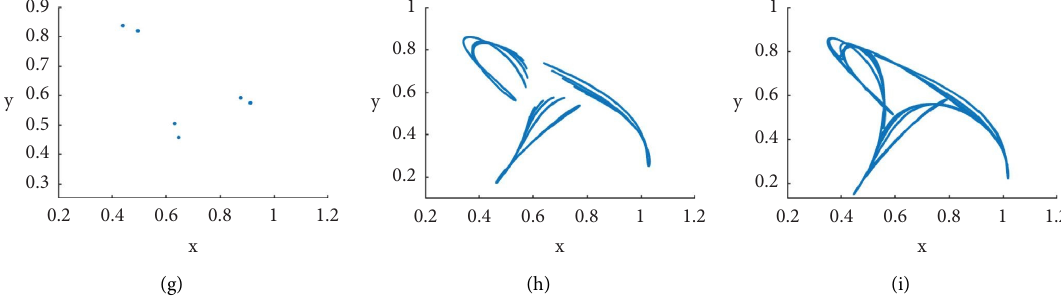
Figure 8: (a) Bifurcation diagram of the model (4) in ( a, x ) plane. (b) Local amplifcation for a ∈ ( 1 . 25 , 1 . 4 ) corresponding to (a). (c) Local amplifcation for a ∈ ( 1 . 4 , 1 . 5 ) corresponding to (a). (d) Maximum Lyapunov exponents corresponding to (a). Phase-plane diagrams for various values of a corresponding to Figure 7(a): (e) a � 0 . 42, (f) a � 1 . 27, (g) a � 1 . 36, (h) a � 1 . 571, and (i) a � 1 .